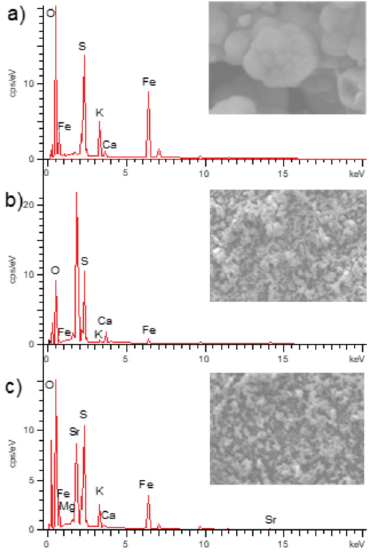
Figure 4. SEM (SE) images of doped jarosite-type compounds: ( a ) JKCa; ( b ) JKCa2; and ( c ) JKAll.